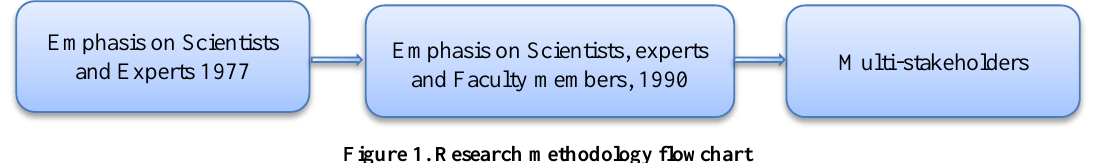
Figure 1. Research methodology